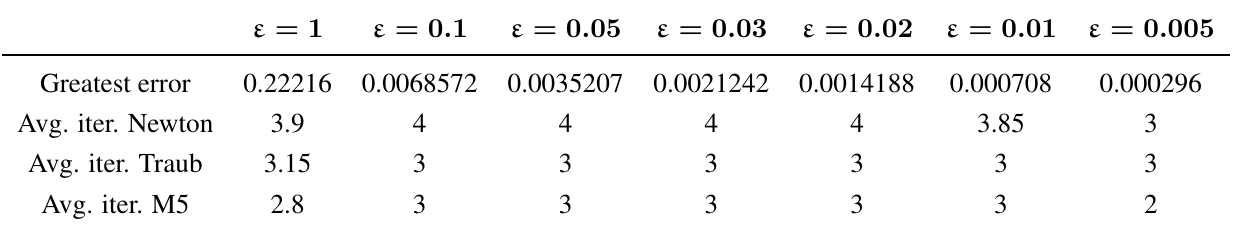
Table 3. Comparison of the GE and methods iterations for different values of ε . ε = 1 ε = 0 . 1 ε = 0 . 05 ε = 0 . 03 ε = 0 .